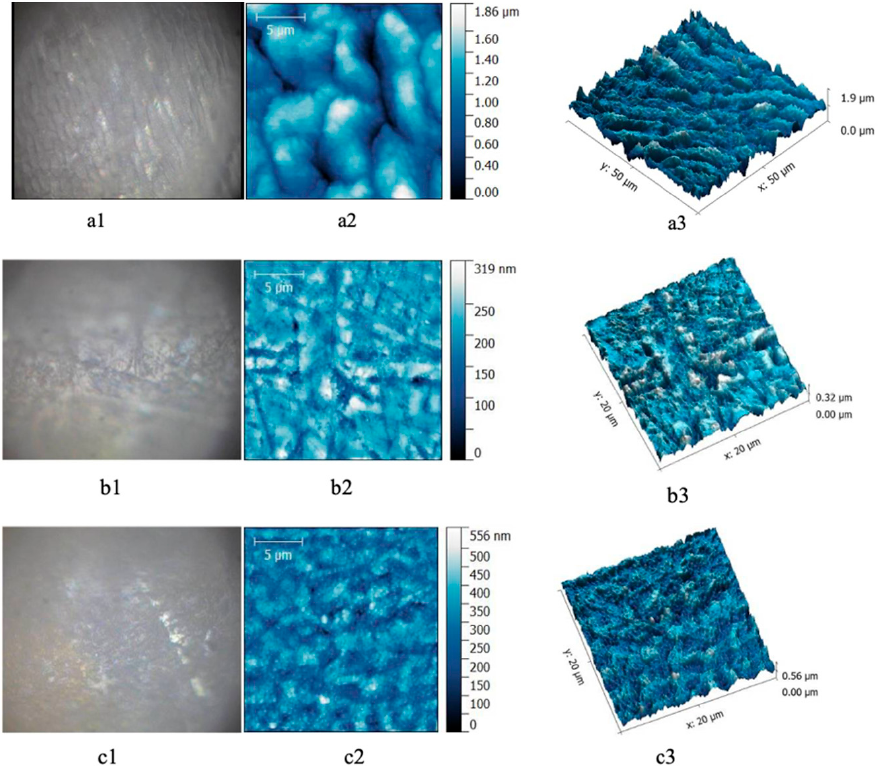
Figure 2. Enamel samples from predialysis patients. ( a ) Before bleaching; ( b ) after 16% gel bleaching; ( c ) after 40% gel bleaching. ( a1 , b1 , c1 ) Optical image; ( a2 , b2 , c2 ) AFM bidimensional image; ( a3 , b3 , c3 ) AFM tridimensional image. Scanning parameters: scanned area for—20 × 20 µ m 2 , 556 × 556 pts, scan frequency—1 Hz, FB 1, scan speed—97.85 µ m/s.